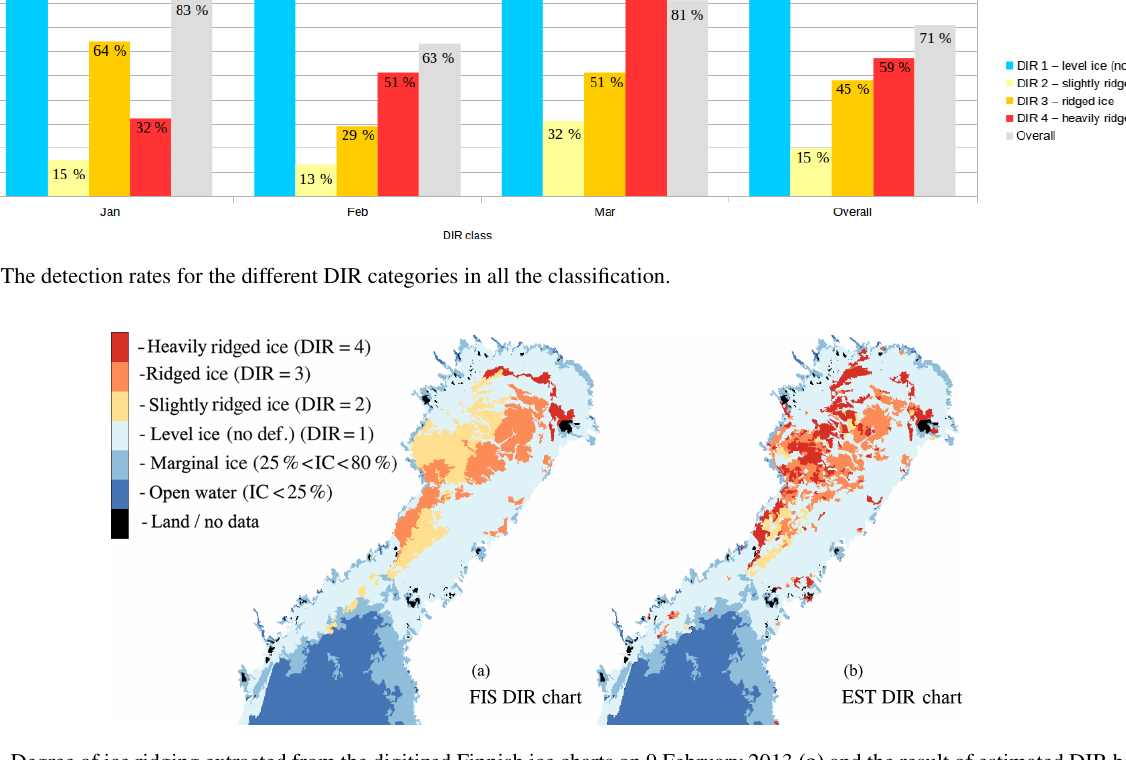
Figure 10. Degree of ice ridging extracted from the digitized Finnish ice charts on 9 February 2013 (a) and the result of estimated DIR based on our RF approach (b) . The DIR charts include the marginal ice zones (25% < IC < 80%) extracted from the ice concentration charts (see Fig.